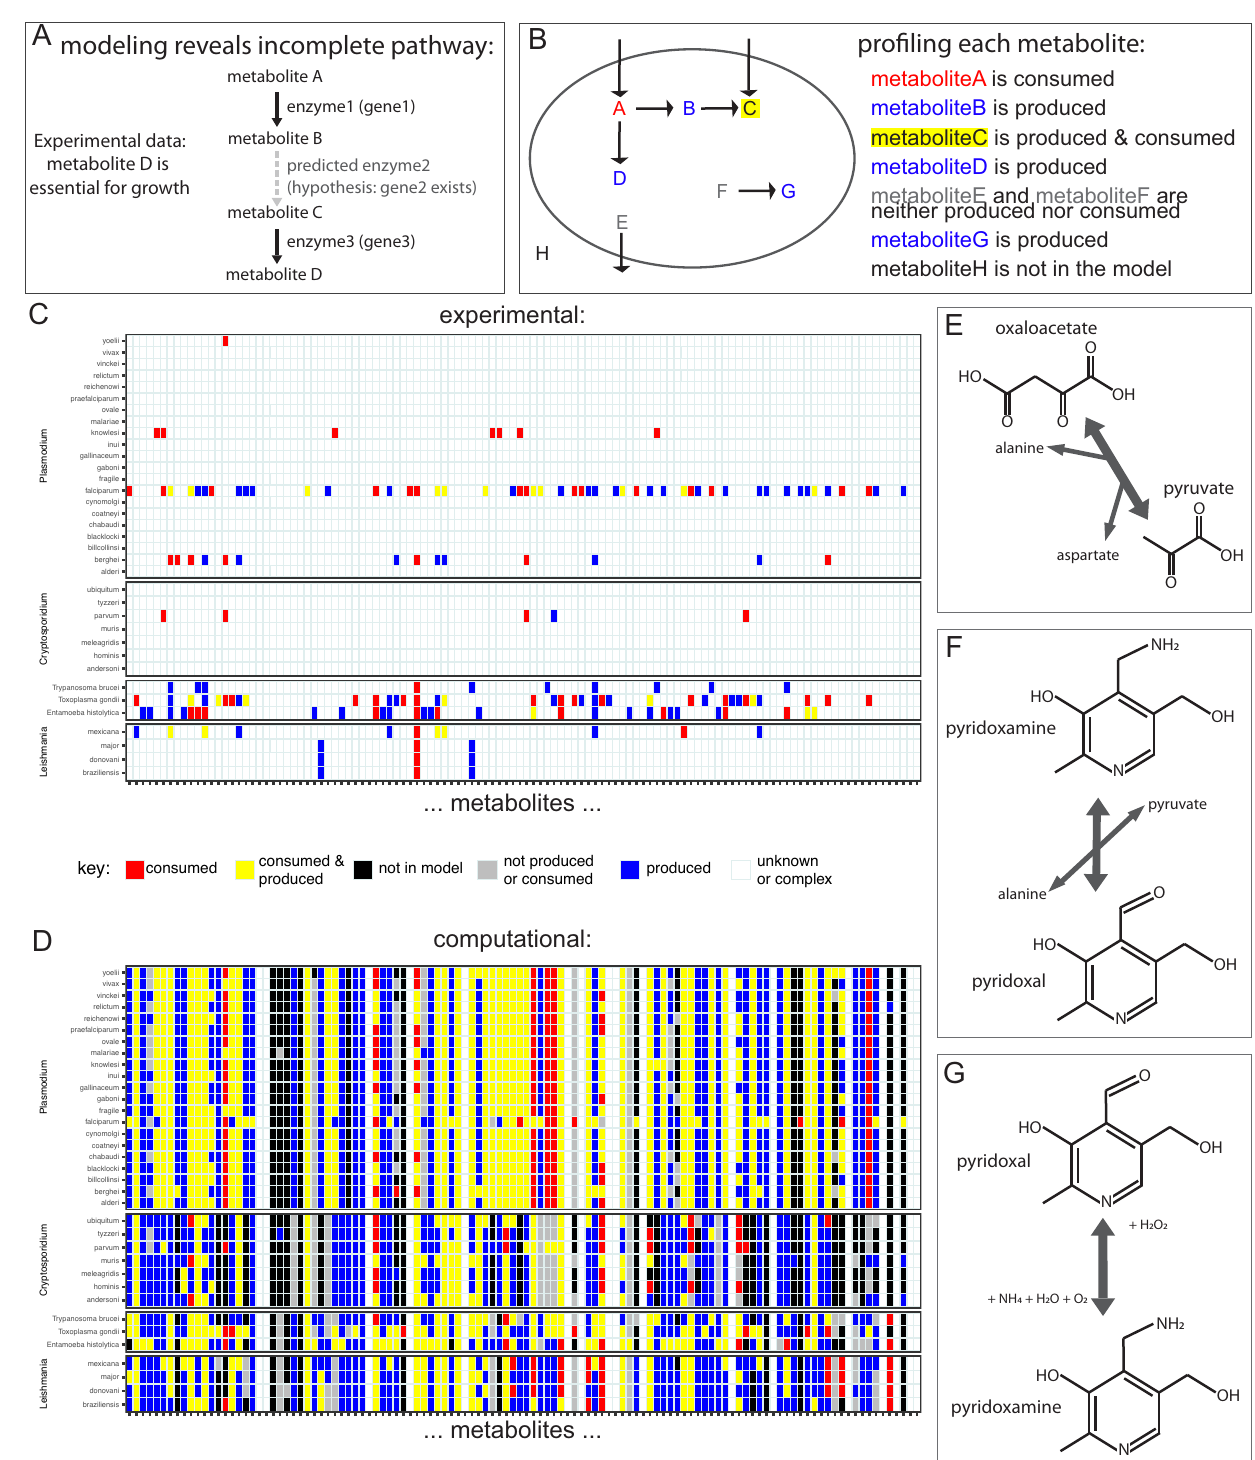
Fig 6. Predicting metabolic function. (A): Advantage of network-based approaches. Metabolic models include hypothetical functions ( i . e . the enzyme encoded by gene2 ) that are unsupported by direct genetic evidence but may be indirectly required based on biochemical evidence. These functions are added through gapfilling. Using models augments our analysis beyond mere genetic comparisons: some enzymes may not be discovered in the genome despite being